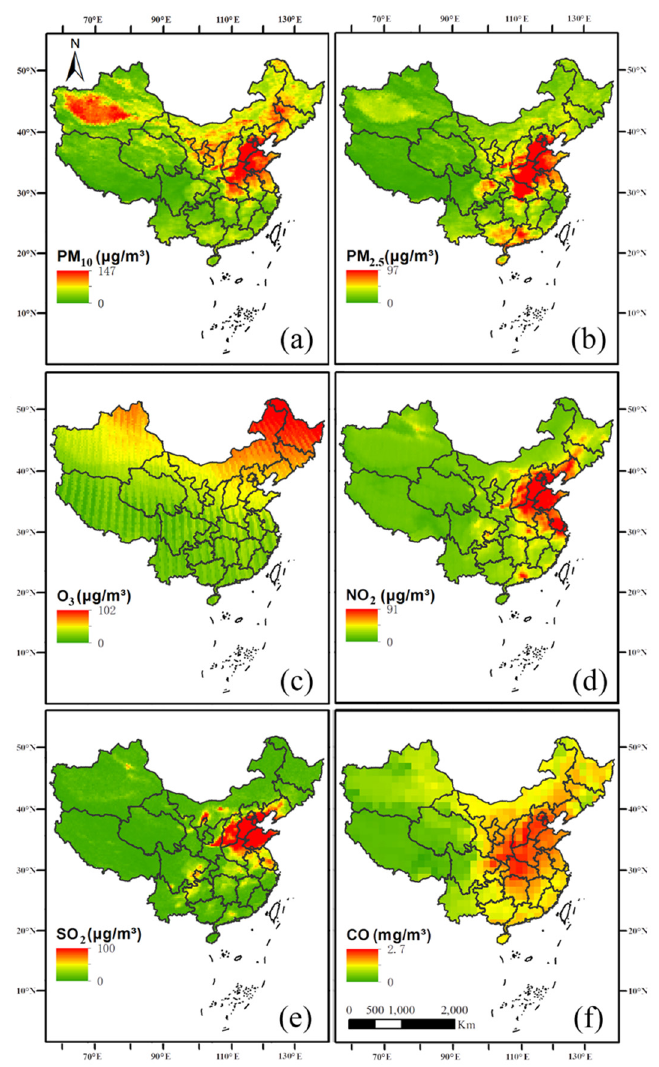
Figure 2. Spatial distribution of 10-year annual average ambient pollutants concentration in China: ( a ) PM 10 ; ( b ) PM 2.5 ; ( c ) O 3 ; ( d ) NO 2 ; ( e ) SO 2 ; ( f ) CO.